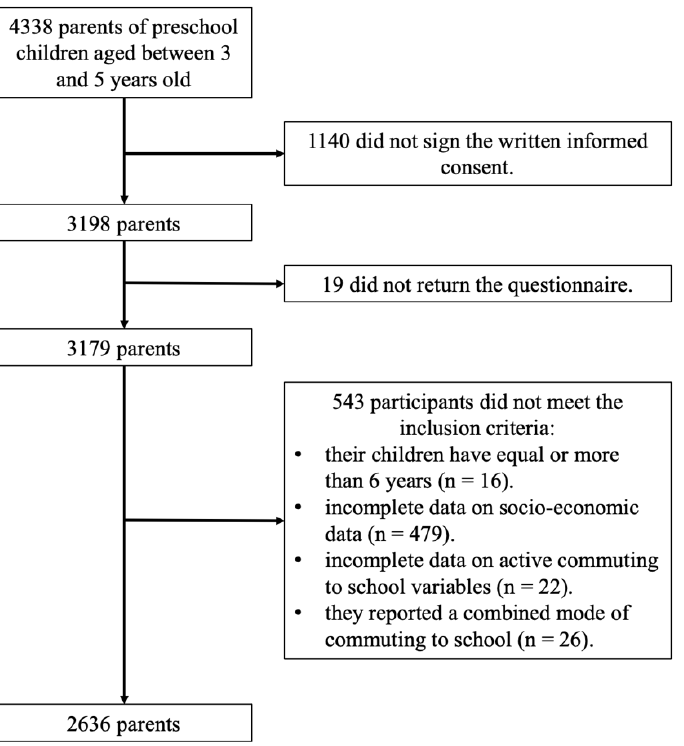
Figure 1. Flowchart of the study sample.